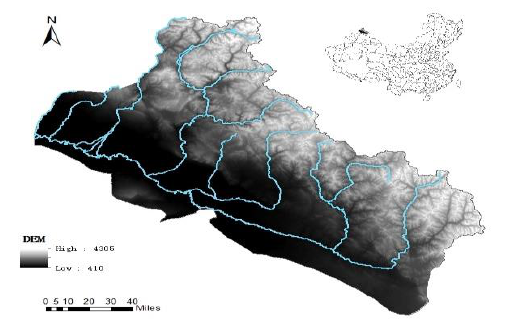
Figure 4. The location of the erzias river basin